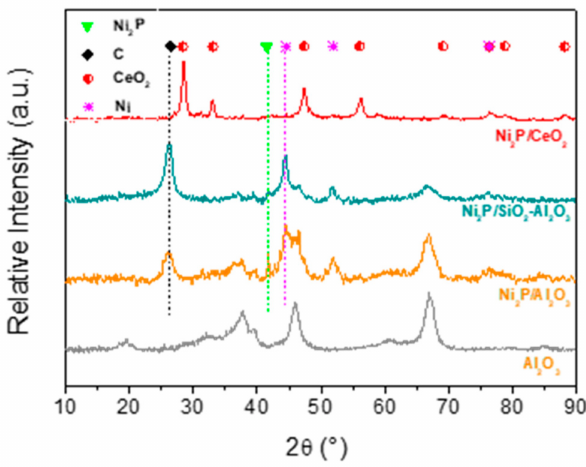
Figure 5. XRD diffractograms obtained for the spent